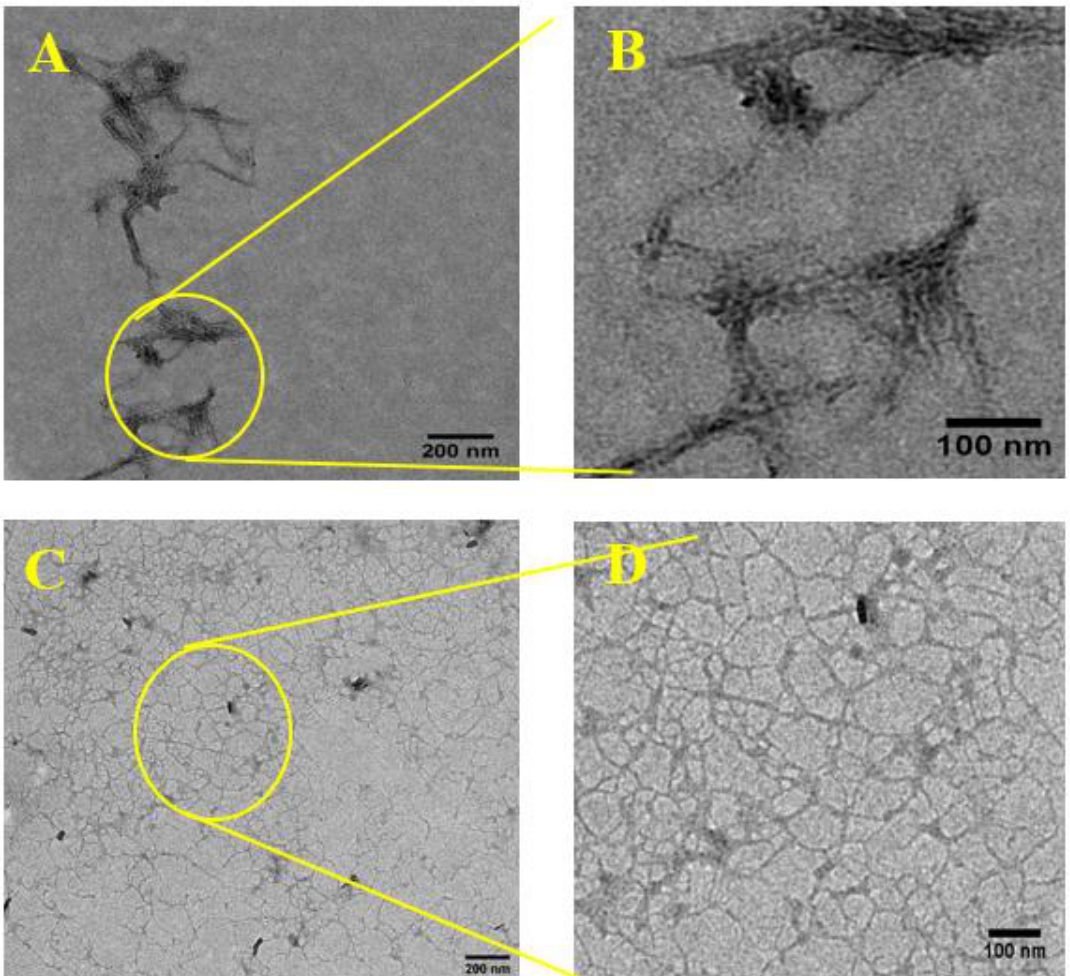
Figure 2. TEM investigation of MCC sourced cellulose nanocrystals (CNC). ( A , B ) depict CNC after 5 min of hydrolysis; ( C , D ) depict CNC after 10 min of hydrolysis.